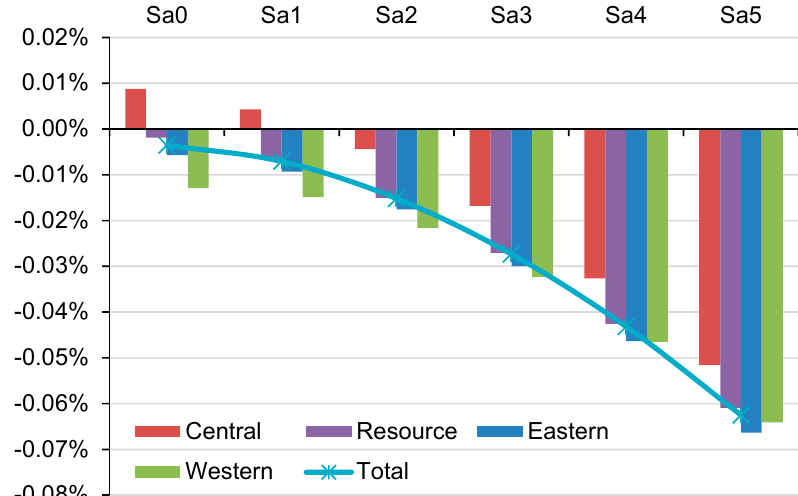
Figure 8. Regional GDP changes under different scenarios.